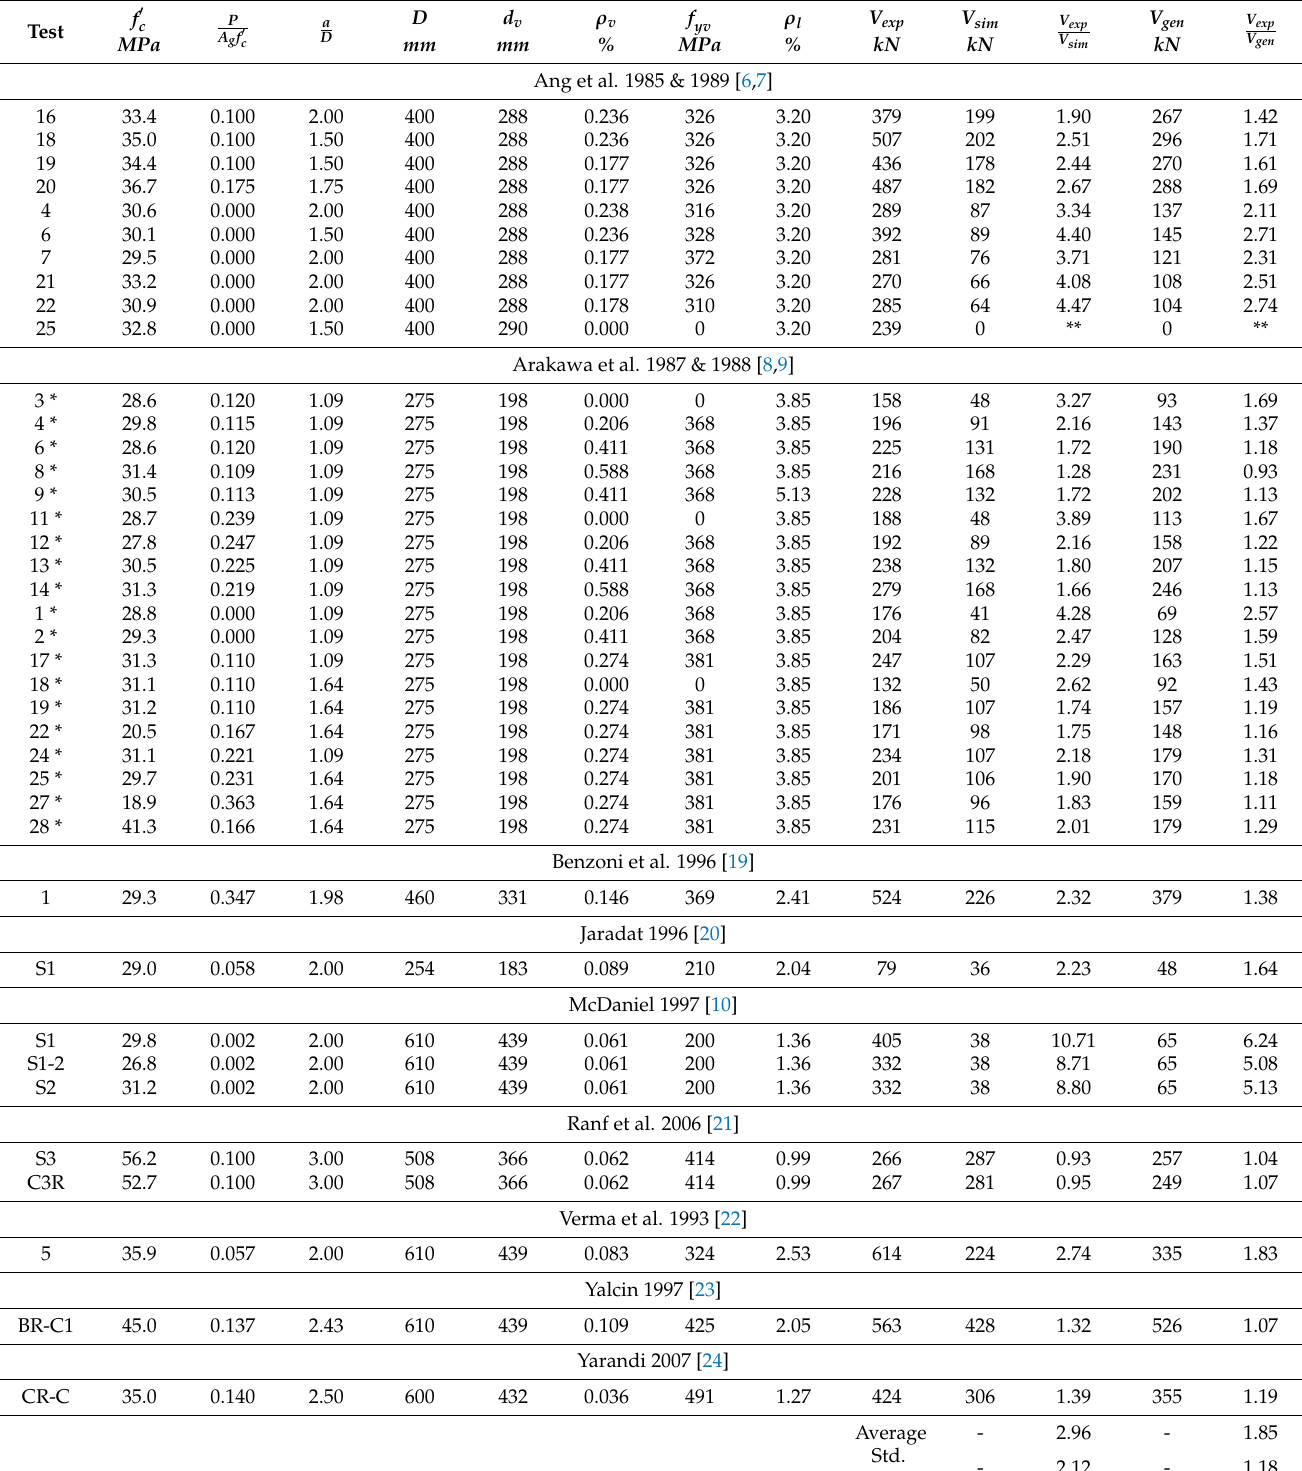
Table 1. Details of circular and octagonal columns and shear strength predictions using the AASHTO Simplified and General